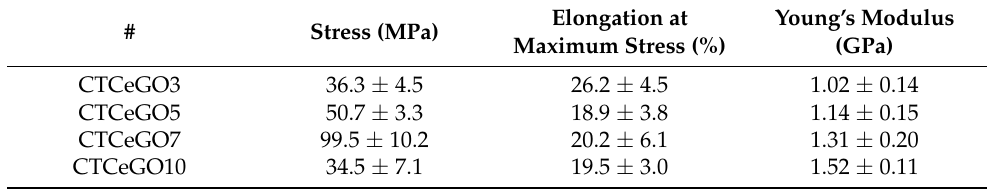
Figure 7 . Strain versus strain graph of the CTA-CeO 2 @GO MMMs with different concentrations of GO. Table 1. Mechanical properties of the synthesized membranes determined at 25 °C